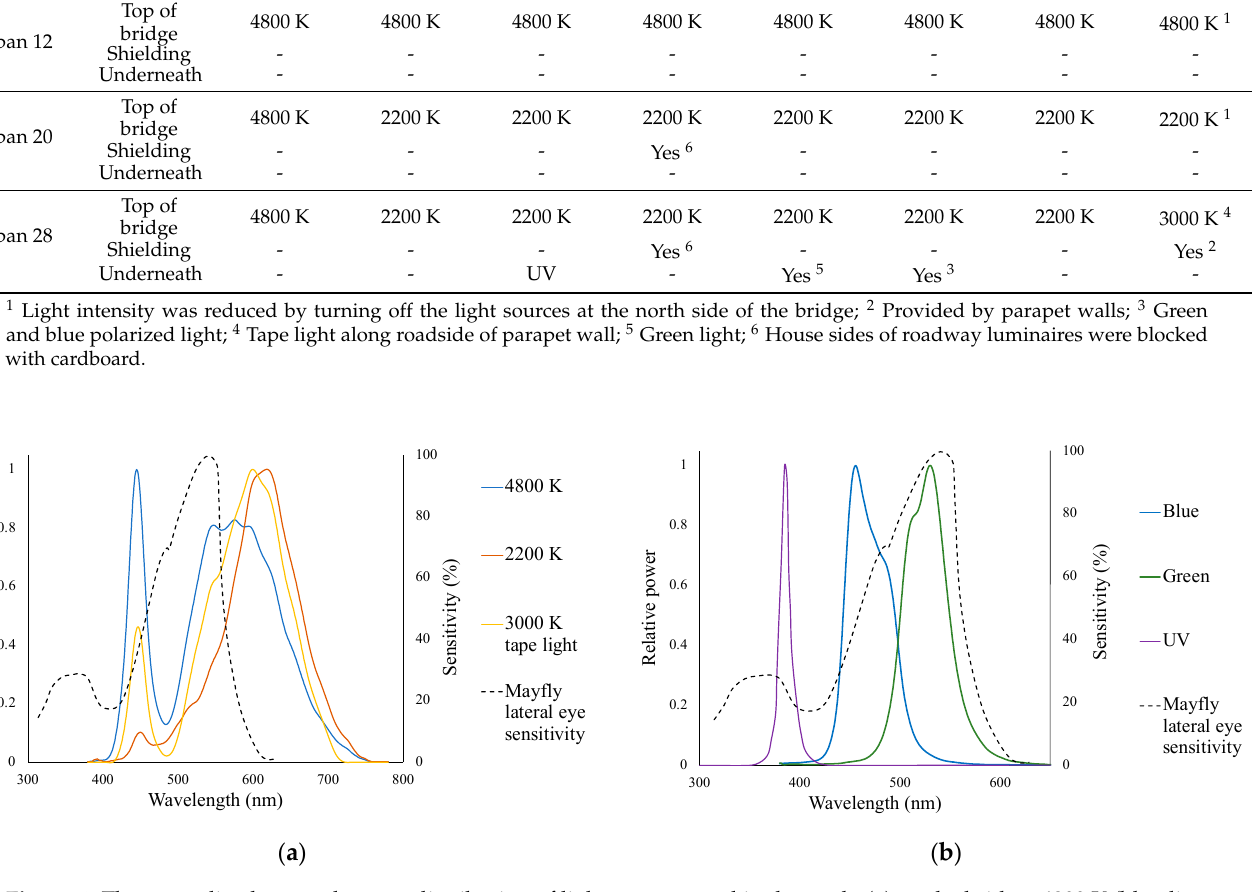
Figure 4. The normalized spectral power distribution of light sources used in the study ( a ) on the bridge: 4800 K (blue line, left graph, left axis), 2200 K (red line, left graph, left axis), and 3000 K (yellow line, left graph, left axis) white light sources; ( b ) under the bridge: blue light (blue line, right graph left axis) and green light (green line, right graph, left axis) lights, and ultraviolet radiation (purple line, right graph, left axis) are shown against the spectral sensitivity of the mayfly lateral eyes (black dotted line, right axes) (after Horridge et al. 1982 [17]).